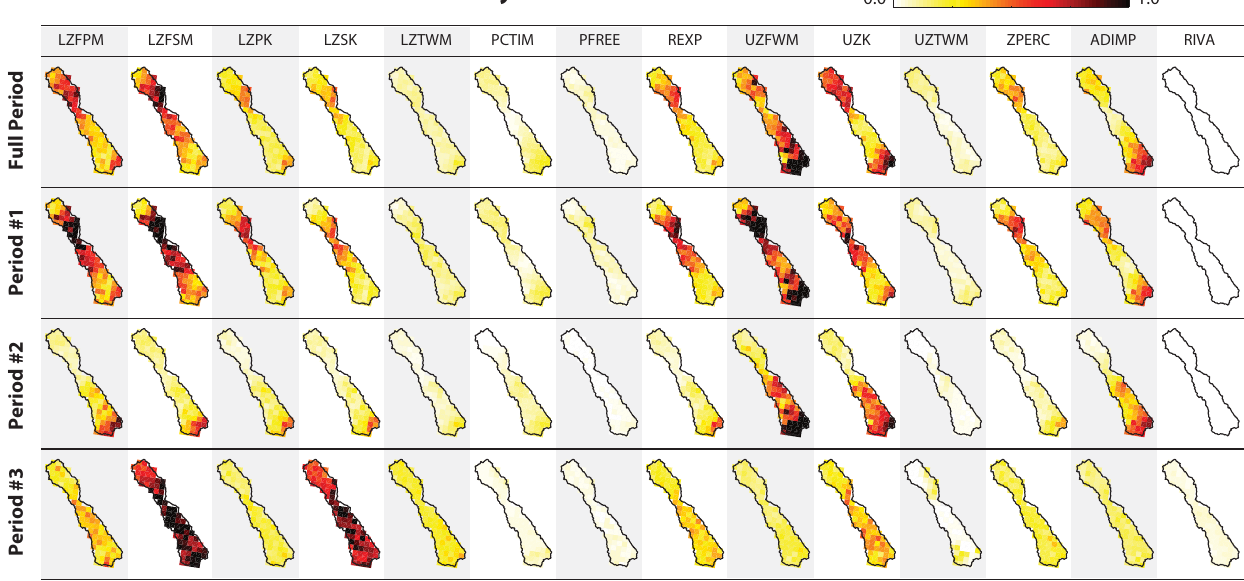
Fig. 4. Full period and event-scale sensitivities of the root mean squared error (RMSE) metric over the full six-month simulation and three selected sub-periods. The µ ∗ values from the method of Morris are scaled to the range [0 , 1] from an initial range of [0 , 0 . 08] . The RMSE metric focuses on the model’s ability to reproduce observed streamflow peaks. The event-scale sensitivity indices differ significantly from those in the aggregated full period depending on the magnitude of the event and the spatial distribution of precipitation.